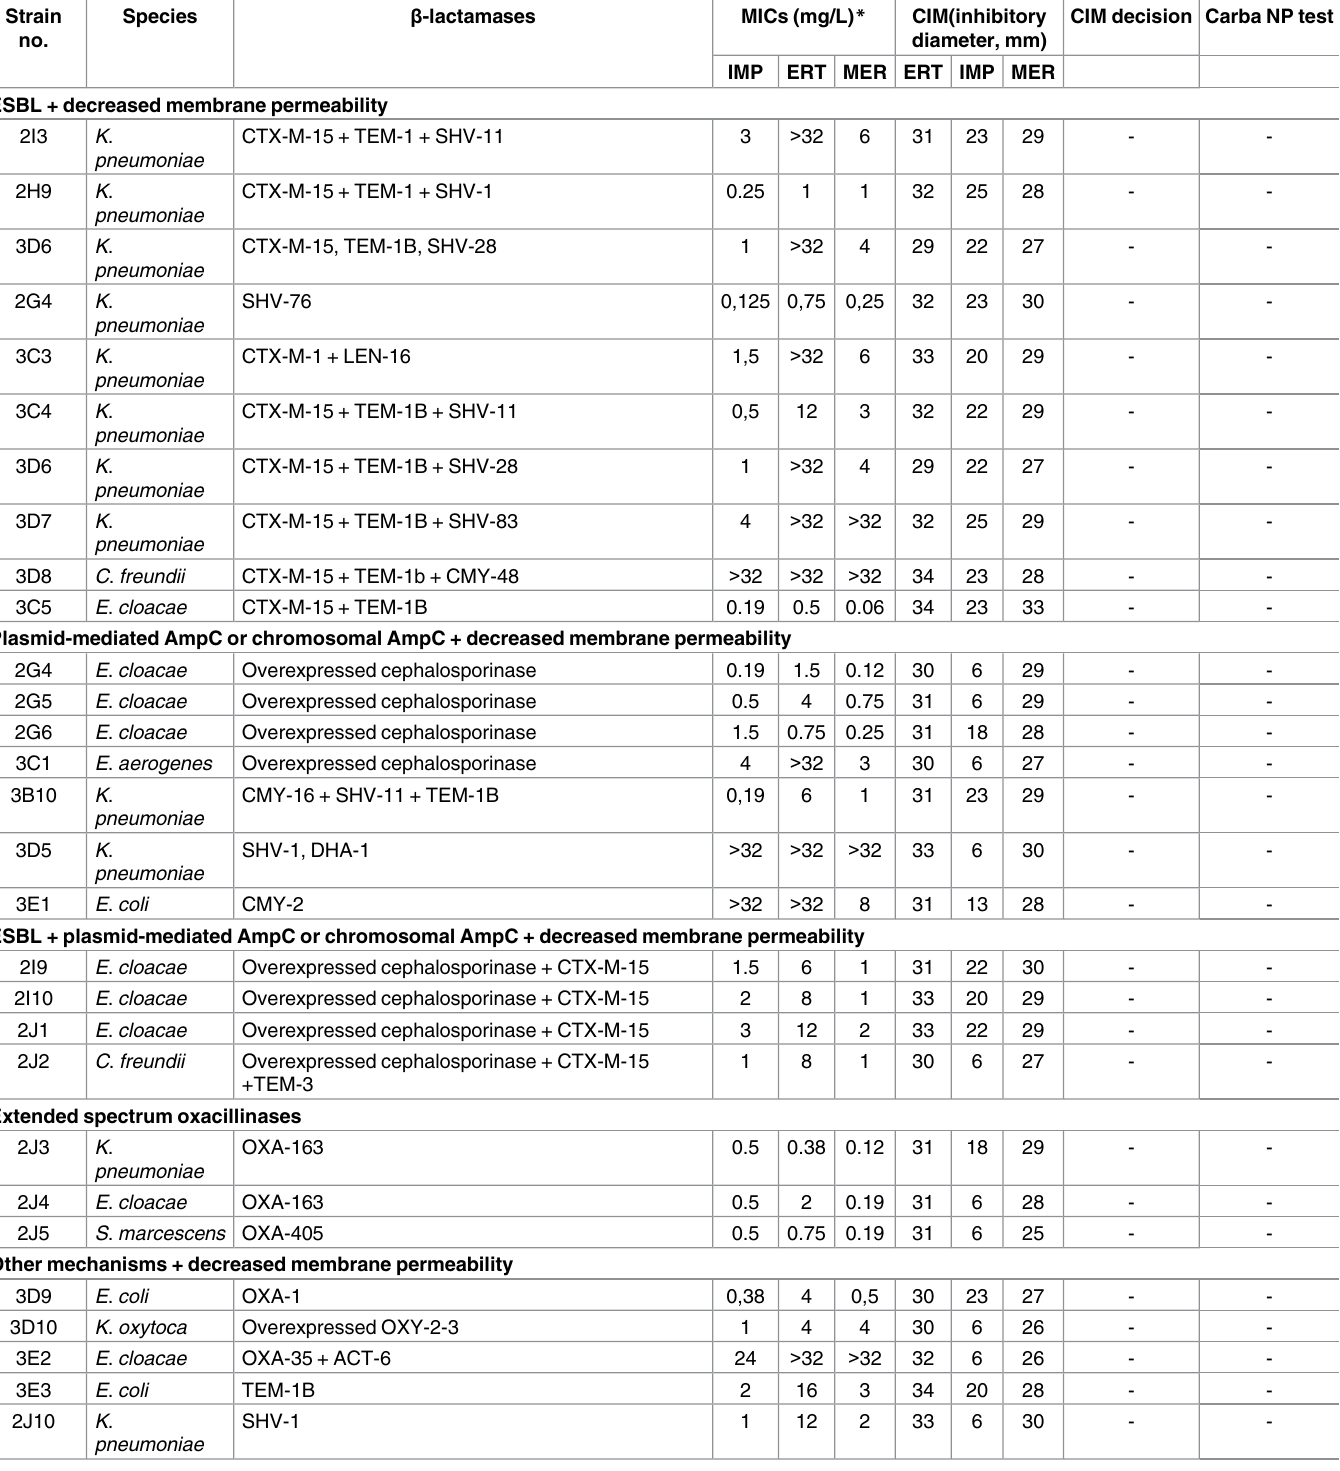
Table 2. Non–carbapenemase-producing enterobacteriaceae subjected to the CIM method, compared to the CarbaNPtest. Strain